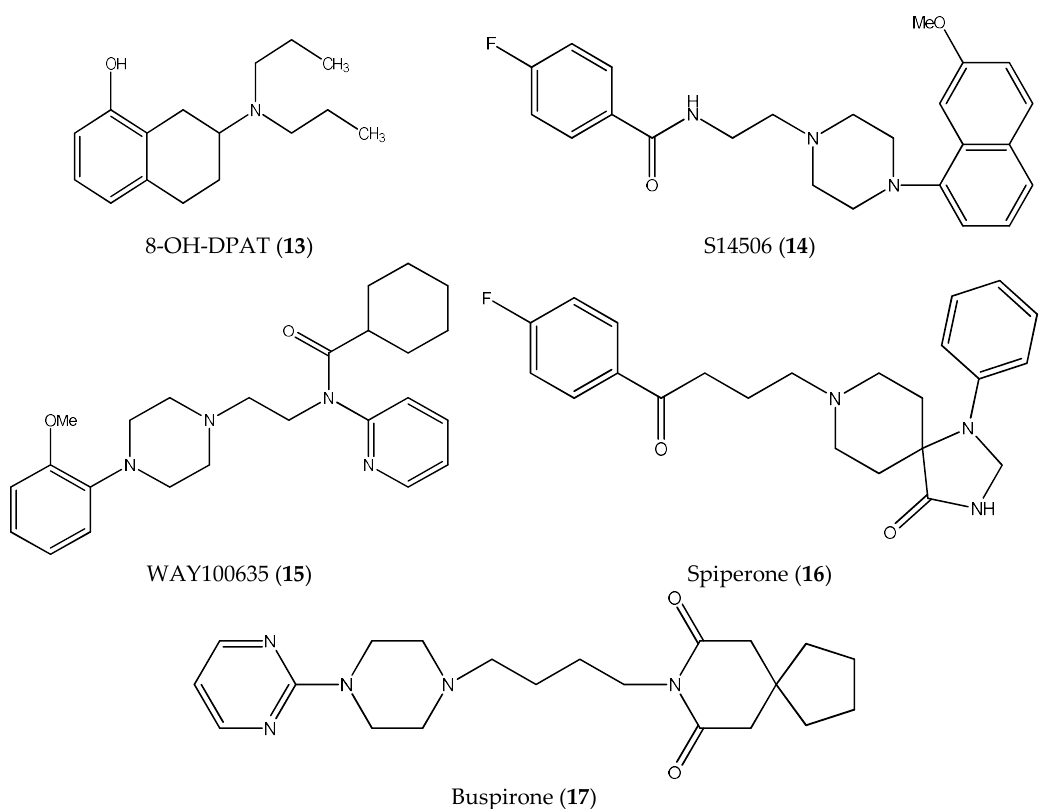
Figure 2. Structures of 5-HT 1A receptor agonists ( 13 , 14 , and 17 ), antagonist ( 15 ) and inverse agonist ( 16 ).